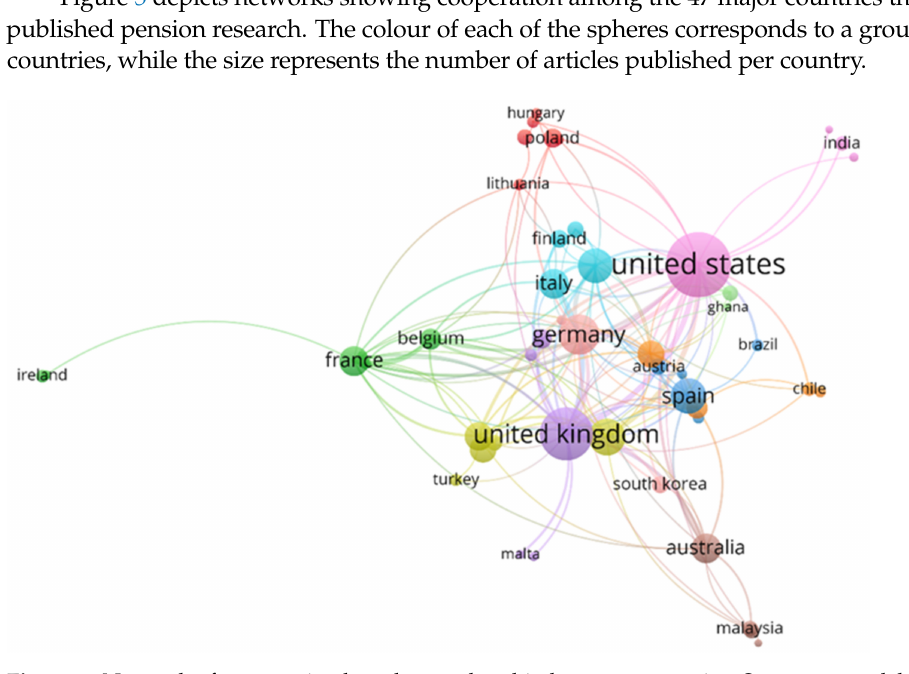
Figure 5. Network of cooperation based on authorship between countries. Source: own